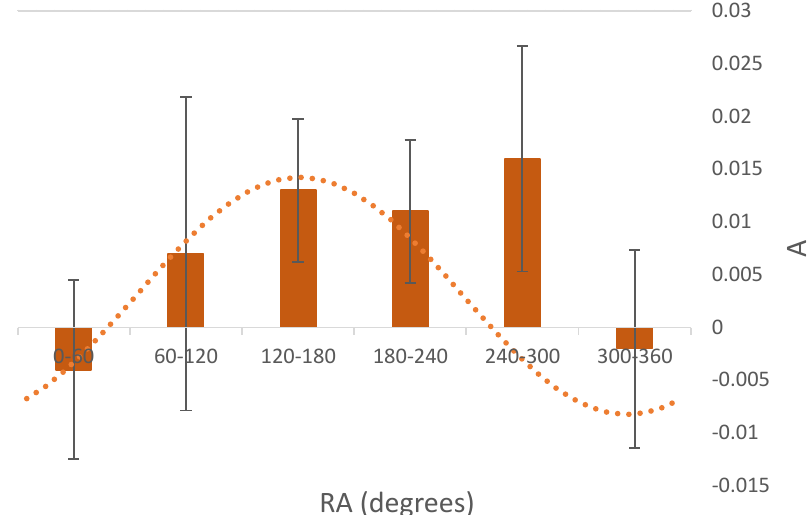
Figure 3. The asymmetry A between the number of galaxies that spin clockwise and the number of galaxies that spin counterclockwise in different 60 ◦ RA ranges. The asymmetry A is defined by A = N cw − N ccw . Each bar shows the asymmetry between clockwise and counterclockwise galaxies in a N cw + N ccw different RA range. The error bars are the normal distribution standard error of 1 √ total number of galaxies in the RA range. The dashed line shows the cosine of the RA centered at RA = 160 ◦ .